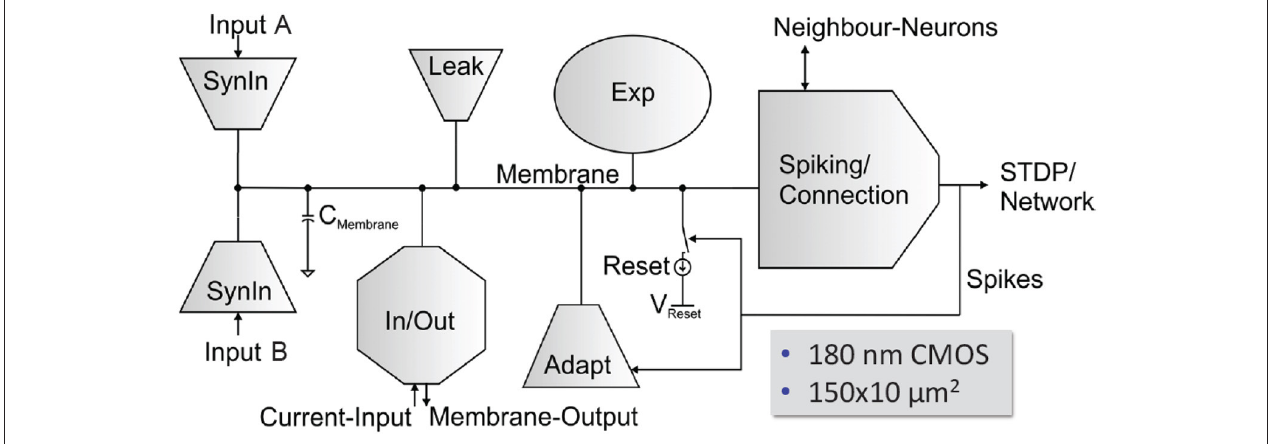
FIGURE 11 | Block diagram of a HICANN membrane circuit. The model neurons are formed by interconnecting groups of membrane